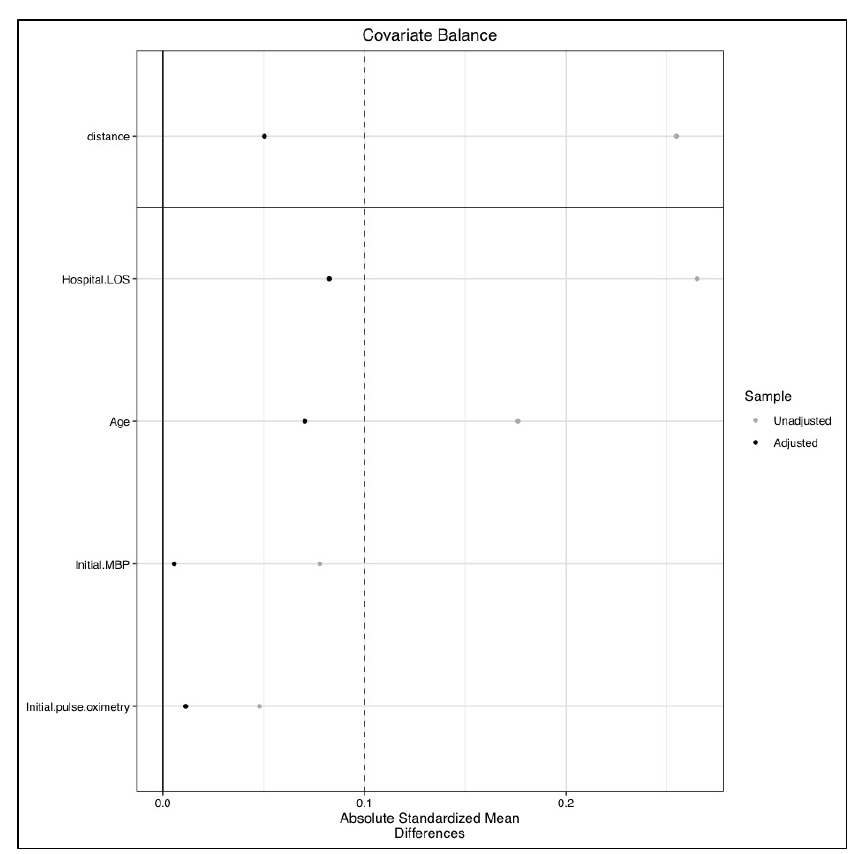
Before Matching n = 171